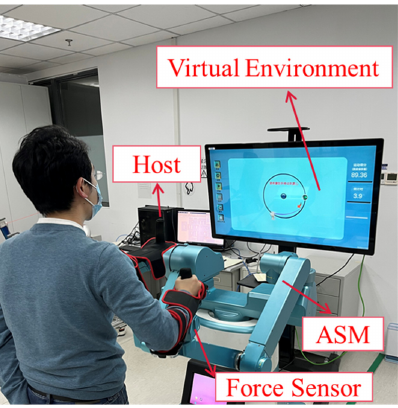
Figure 11. The subject was participating in an experiment with a circle drawing task.